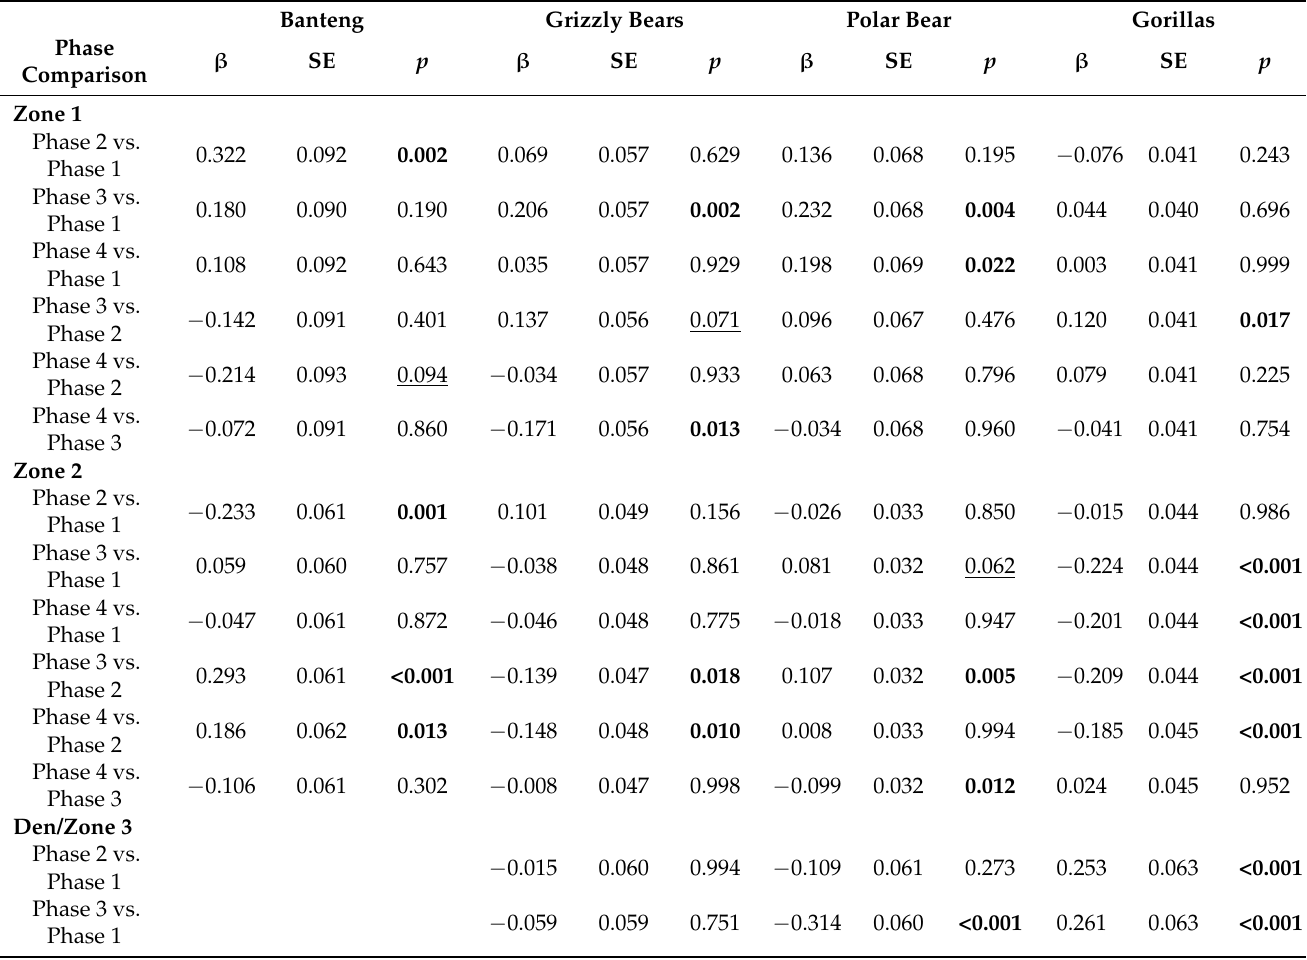
Table 4. Pairwise comparisons of zone occupancy by phase for each